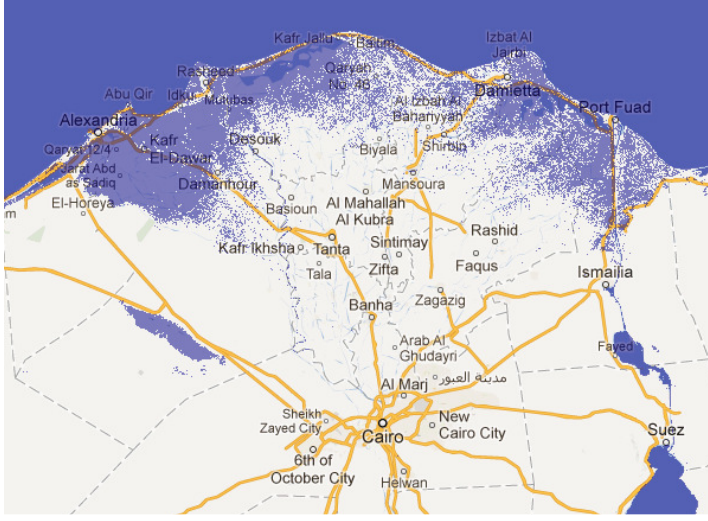
Figure 2. The effect of a sea level rise (SLR) of 1 m on Egypt’s north coast and Nile Delta